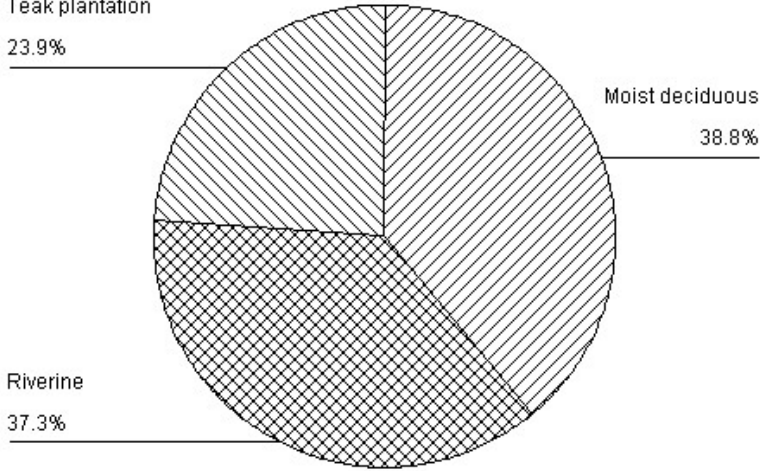
FIGURE 2 . Spatial pattern of insect